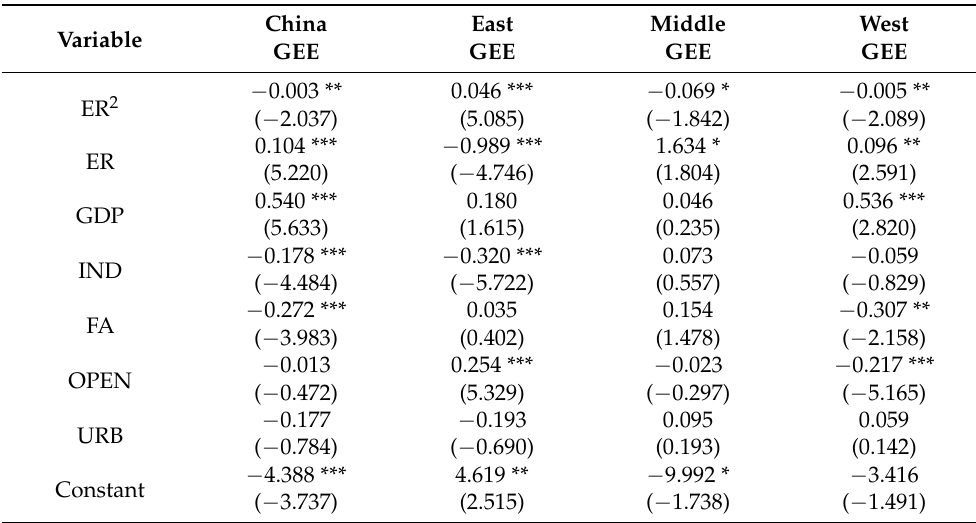
Table 3. Regression results for Tobit